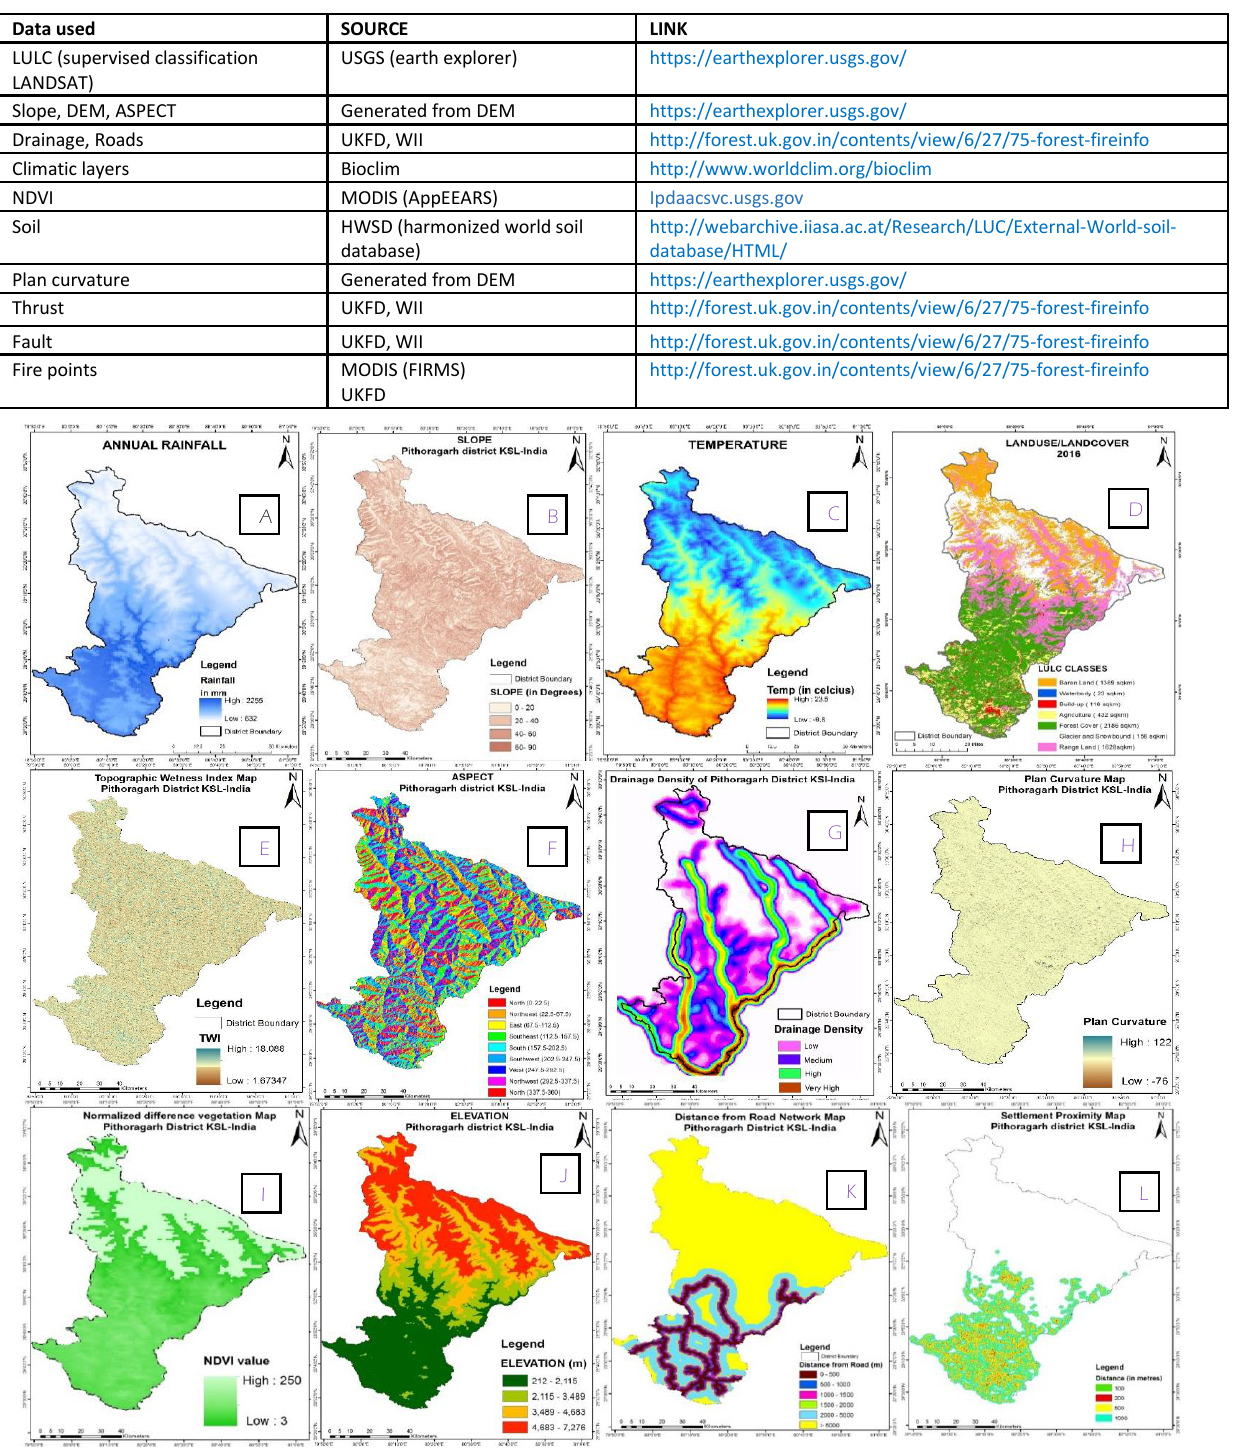
Table 1: Data sets used for in landscape vulnerability analysis in KSL-India.